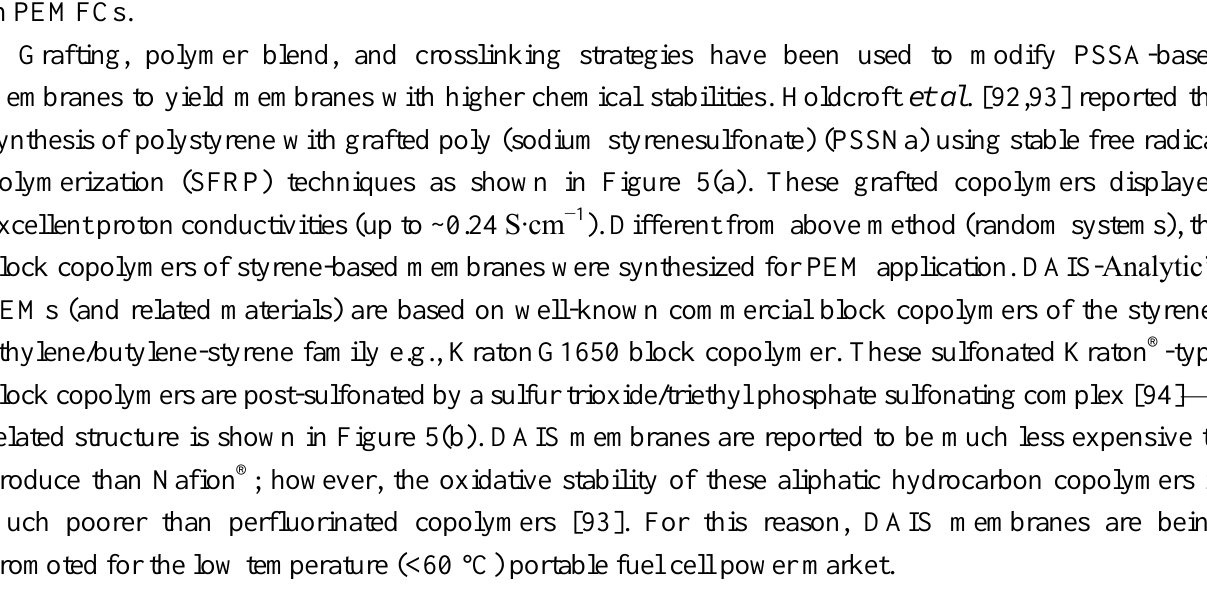
5. Chemical structure of ( a ) PS- g -PSSA and ( b ) sulfonated sulfonated styrene-(ethylene-butylene) styrene (SEBS) block